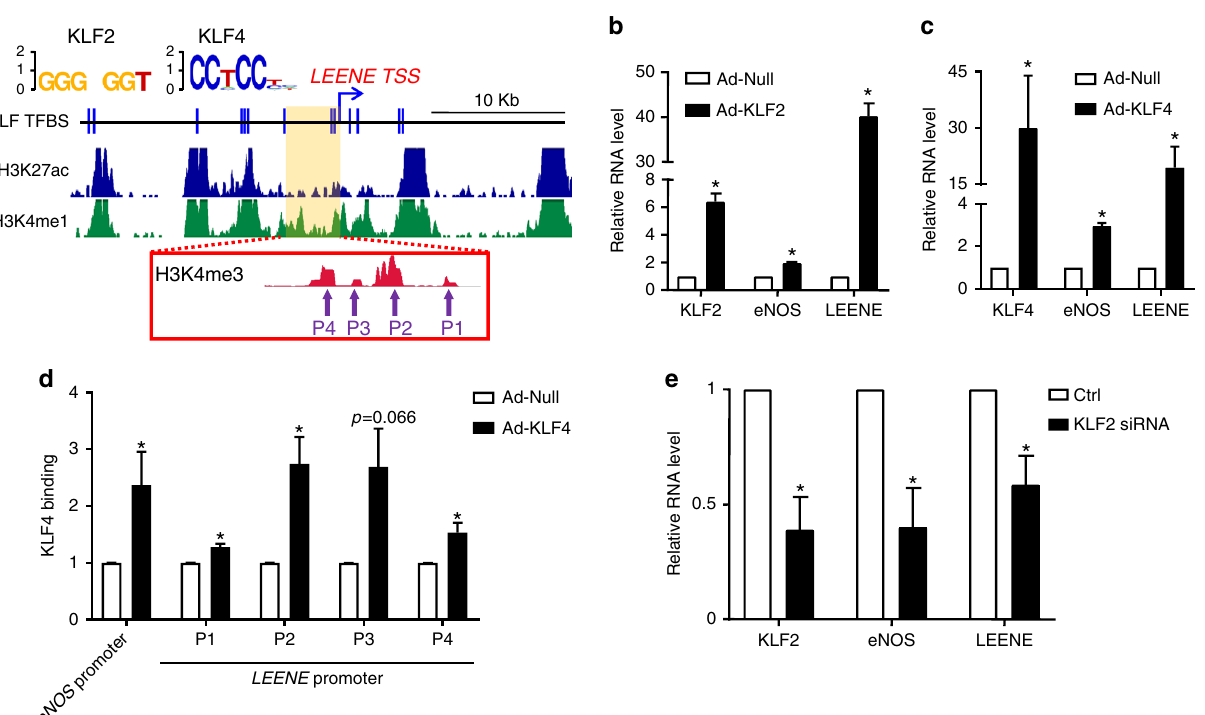
Fig. 2 KLF2 and KLF4 transcriptionally regulate LEENE. a Putative KLF2 and KLF4 binding sites in LEENE enhancer/promoter based on the conserved KLF2 and KLF4 binding motifs (shown on the top). Middle tracks display H3K27ac and H3K4me1 ChIP-seq signals in LEENE locus, and the inset shows H3K4me3 ChIP-seq signals in the putative LEENE promoter region from ENCODE HUVEC data; arrows indicate regions detected in ChIP-qPCR (Fig. 2d). b – d HUVECs were infected with respective adenoviruses for 48 h. RNA levels of KLF2, KLF4, LEENE, and eNOS were detected by qPCR (in b and c ) and KLF4 binding to promoters of eNOS and LEENE was quanti fi ed by ChIP-qPCR analysis (in d ). e qPCR of respective RNA levels in ECs transfected with scramble control (Ctrl) or KLF2 siRNA. Data are presented as mean ± SEM, n = 5 in each group. * p < 0.05 compared to respective controls using Student ’ s t